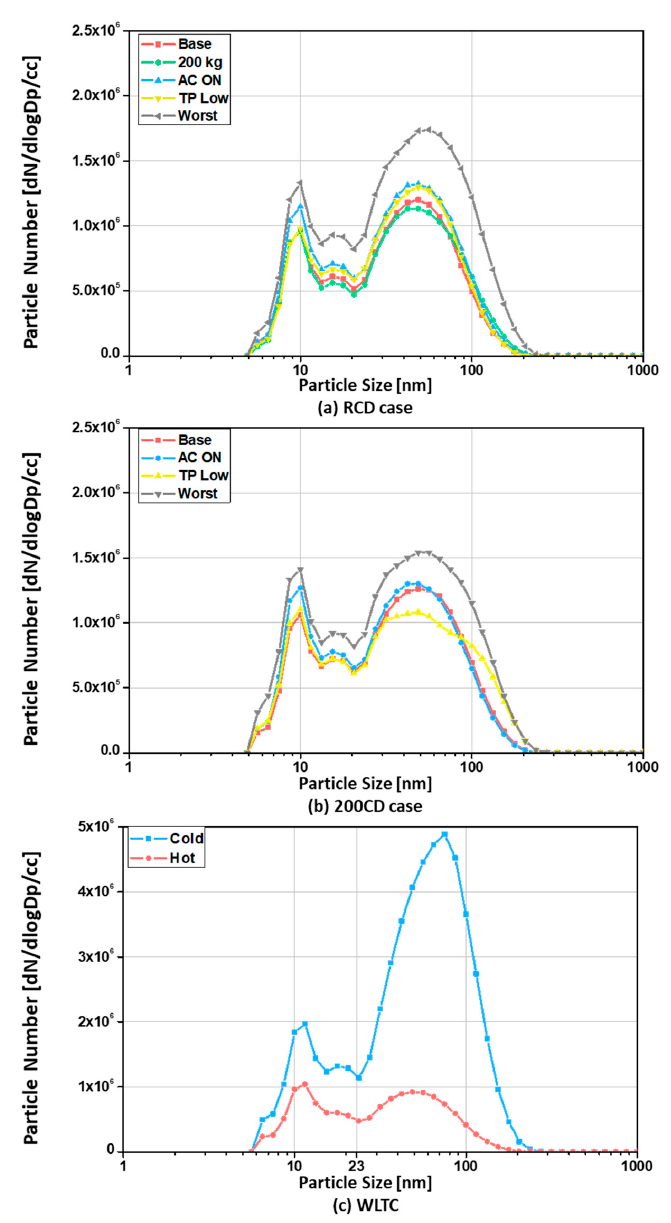
Figure 6. Size-resolved PN concentration with various CD values and in worldwide harmonized light-duty vehicle test procedure (WLTP) mode.